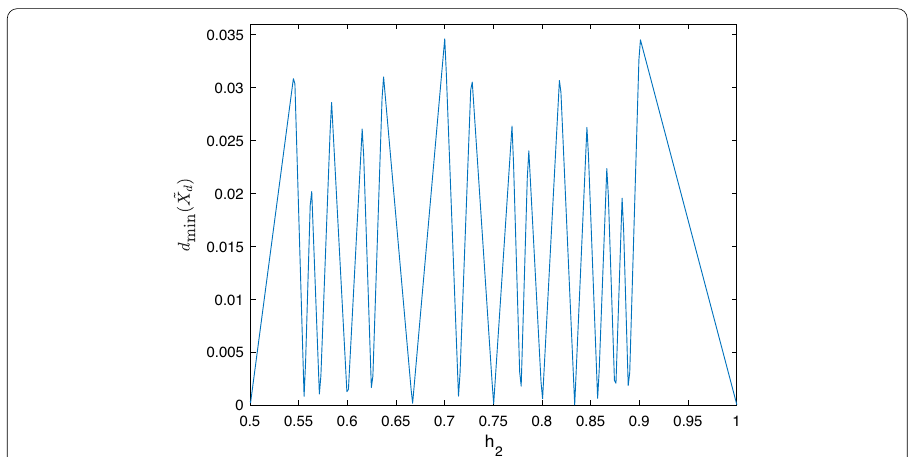
10 as a function of h 2 with =